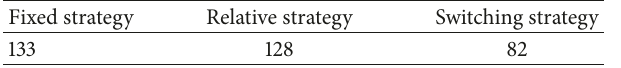
Table 2: Times of triggering